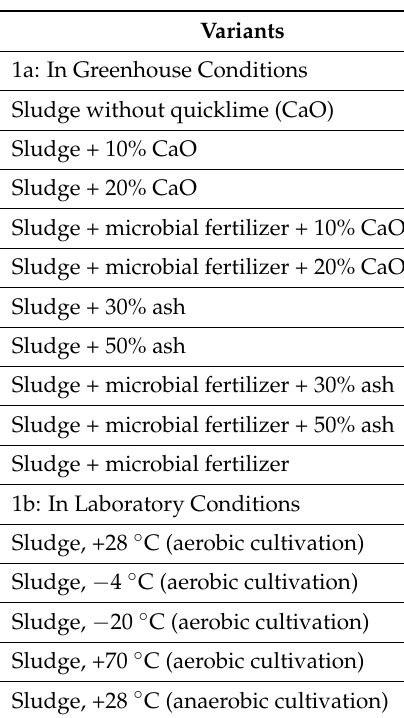
Table 1. Scheme of variants and period of microbiological